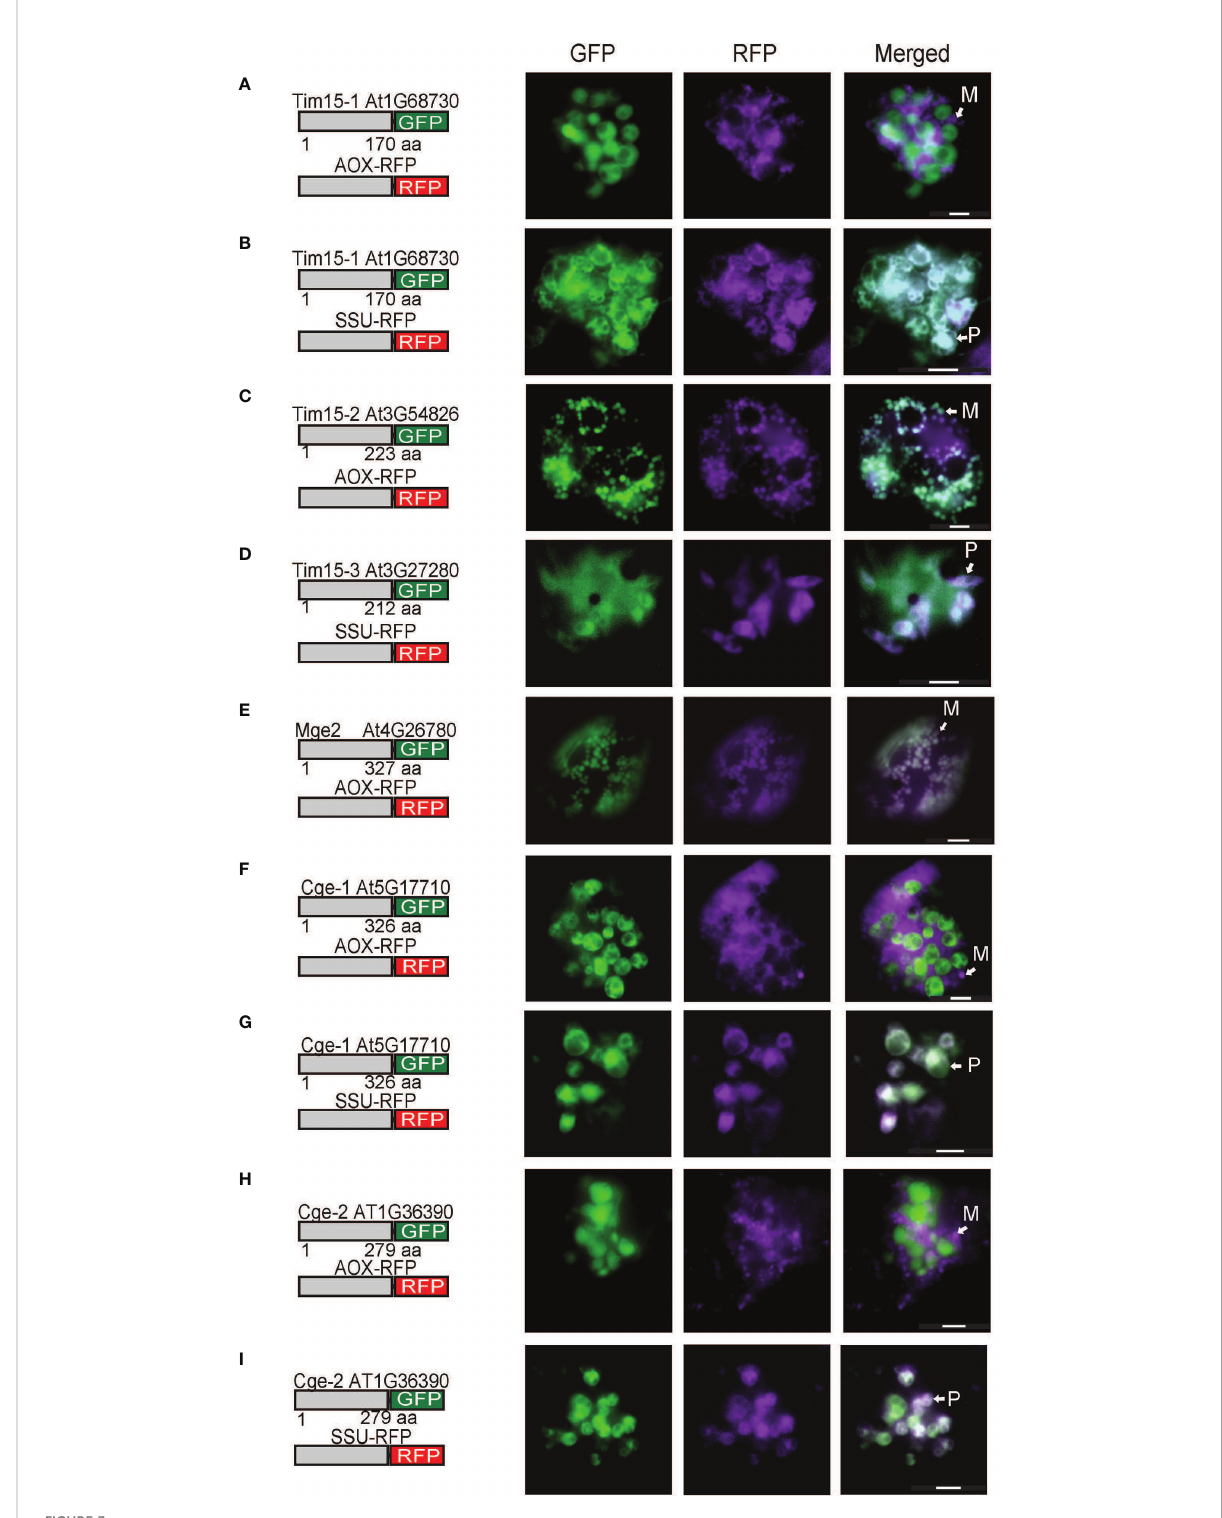
FIGURE 3 Biolistic transformation and localisation assays of Arabidopsis Tim15, Mge2 and Cge1/2 GFP. C-terminal GFP fusions transformed into Arabidopsis cell suspensions alongside a mitochondrial targeted RFP (AOX-RFP) or plastid targeted RFP (SSU-RFP). Tim15-1 (A, B) . Tim15-2 (C) . Tim15-3 (D) . Mge2 (E) . Cge1 (F, G) . Cge2 (H, I) . Scale bar indicates 20 m m. M, mitochondria; P,